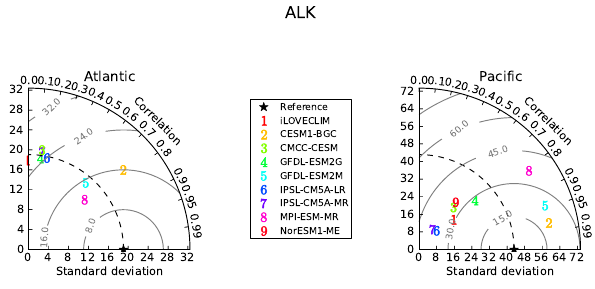
Figure 21. Comparison of the latitude–depth pattern of zonally averaged alkalinity in the Atlantic and Pacific basins (Taylor dia- grams). Data from GLODAP (Key et al., 2004).